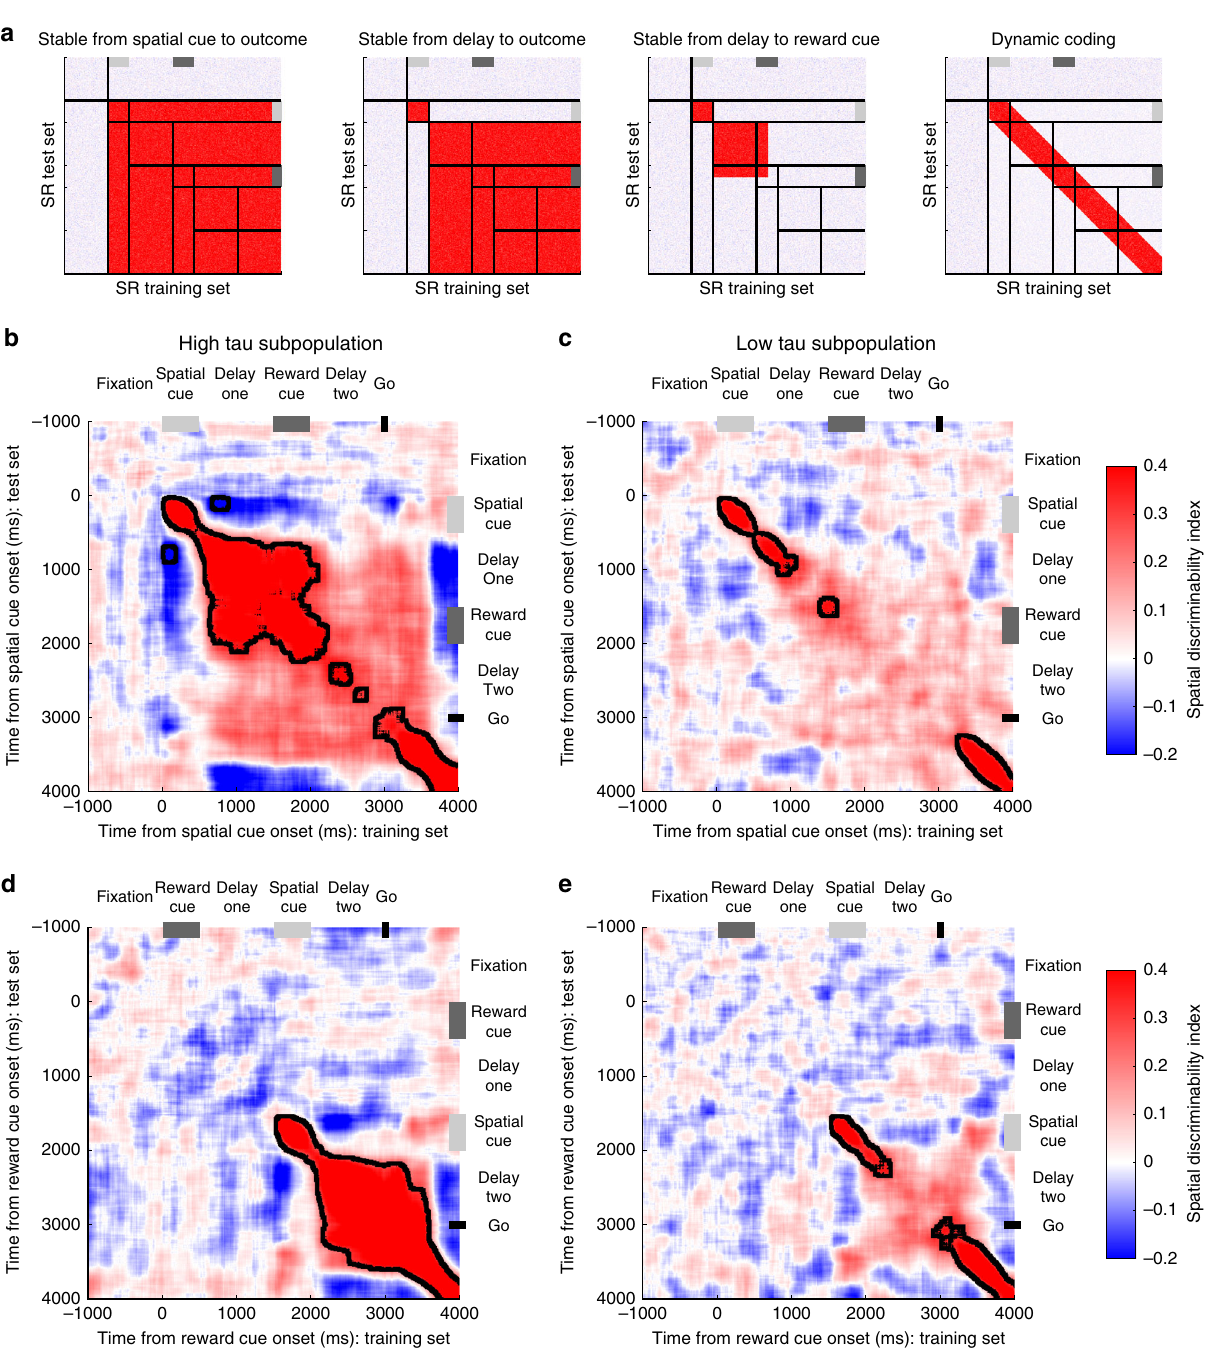
Fig. 4 Cross-temporal dynamics of spatial selectivity by high and low time-constant populations. a Schematic representing cross-temporal dynamics of different working-memory codes on SR-trials. Each pixel represents how well spatial location can be discriminated when using half of the trials at one timepoint as a training set ( X -axis), and the other half of trials at a separate timepoint as a test-set ( Y -axis). Off diagonal, the plot indicates the stability of any spatial coding across time. In the fi rst exemplar, stable spatial coding is evident across the trial, as data from any timepoint after cue presentation can be used to decode the remembered spatial location at any other timepoint. The second exemplar is similar, but this stable state is only established following a transient dynamic phase where the cue is initially encoded. The third exemplar shows that this stable state is established during the initial delay — but collapses after the reward cue is presented. The fi nal exemplar shows that spatial location is coded throughout the trial (heat on the diagonal), but that this code is not stable across time. b – e Cross-temporal decodability of spatial location is plotted for high ( b , d ) and low ( c , e ) time-constant VLPFC populations on SR ( b , c ) and RS (d , e) trials. The high time-constant subpopulation has greater stability of spatial coding: the off-diagonal elements are warm, meaning that the same population code persists throughout the delay epoch following the spatial cue. Despite this stability, there is a negative correlation between the cue period and the delay indicating a reversal of spatial tuning between these epochs. In SR-trials, a stable state is reached during delay-one, but this is disrupted by the presentation of the reward cue, and there is only a weak non-signi fi cant cross-temporal generalisation between delay-one and delay-two. A dynamic, rather than stable, representation of space returns around the time of the go cue. In the low time-constant population, coding is always dynamic, so no stable state is established. Black lines encircling areas of strong coding indicate signi fi cant cross-temporal stability ( p <0.05, cluster-based permutation test,